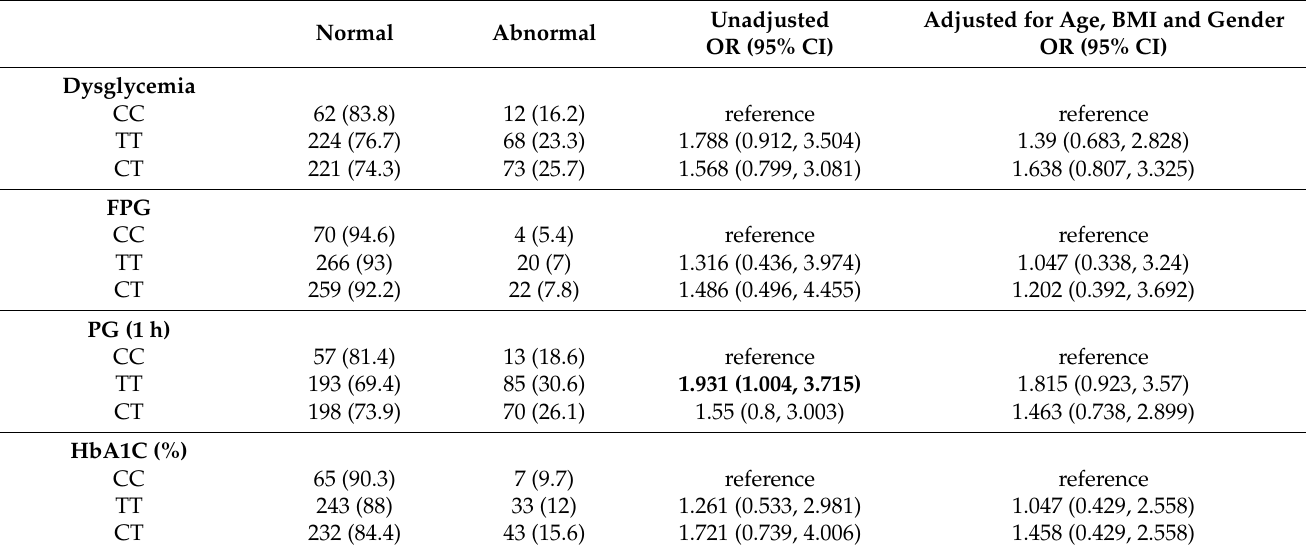
Table 4. Logistic regression analysis of dysglycemic abnormalities and the three genotypes of the ABCA1 C69T gene.